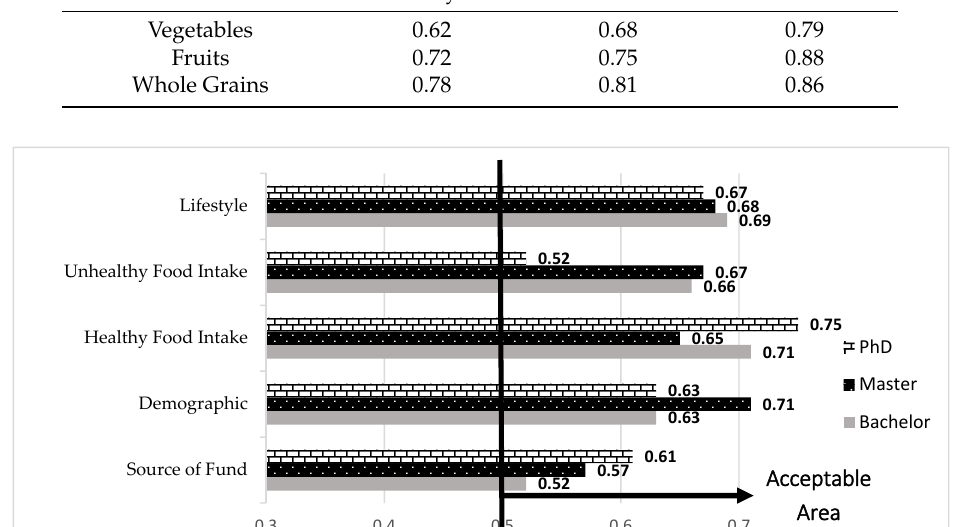
Figure 3. AVE (average variance extracted) analysis outputs.